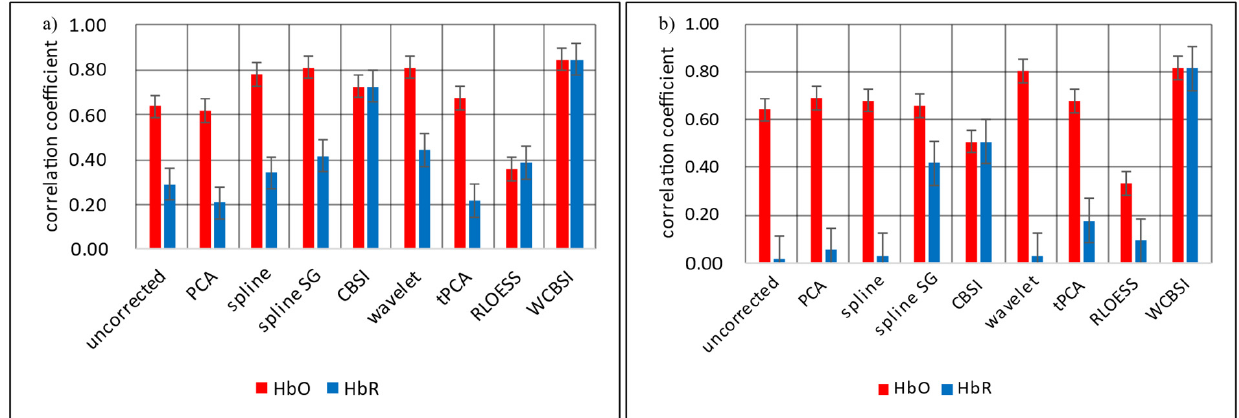
Figure 6. Average Pearson correlations of the MA corrected HbO and HbR signals with the reference signals. These are shown in ( a ) for the SHM responses and in ( b ) for the LHM responses. The correlations were calculated individually for each participant and then averaged. Correction types are uncorrected, principal component analysis (PCA), spline interpolation, spline interpolation plus Savitzky–Golay filtering (splineSG), correlation-based signal improvement (CBSI), wavelet transform, targeted principal component analysis (tPCA), robust locally estimated scatter plot smoothing (RLOESS), and our new combination of wavelet and CBSI correction (WCBSI). Error bars indicate standard error across participants.